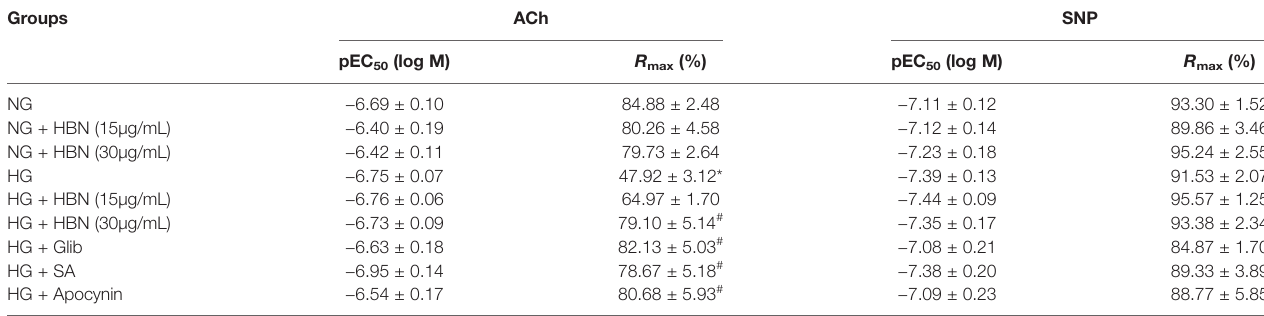
Results are means ± SEM (n = 6). *P < 0.05 compared with NG, # P < 0.05 when compared with HG.